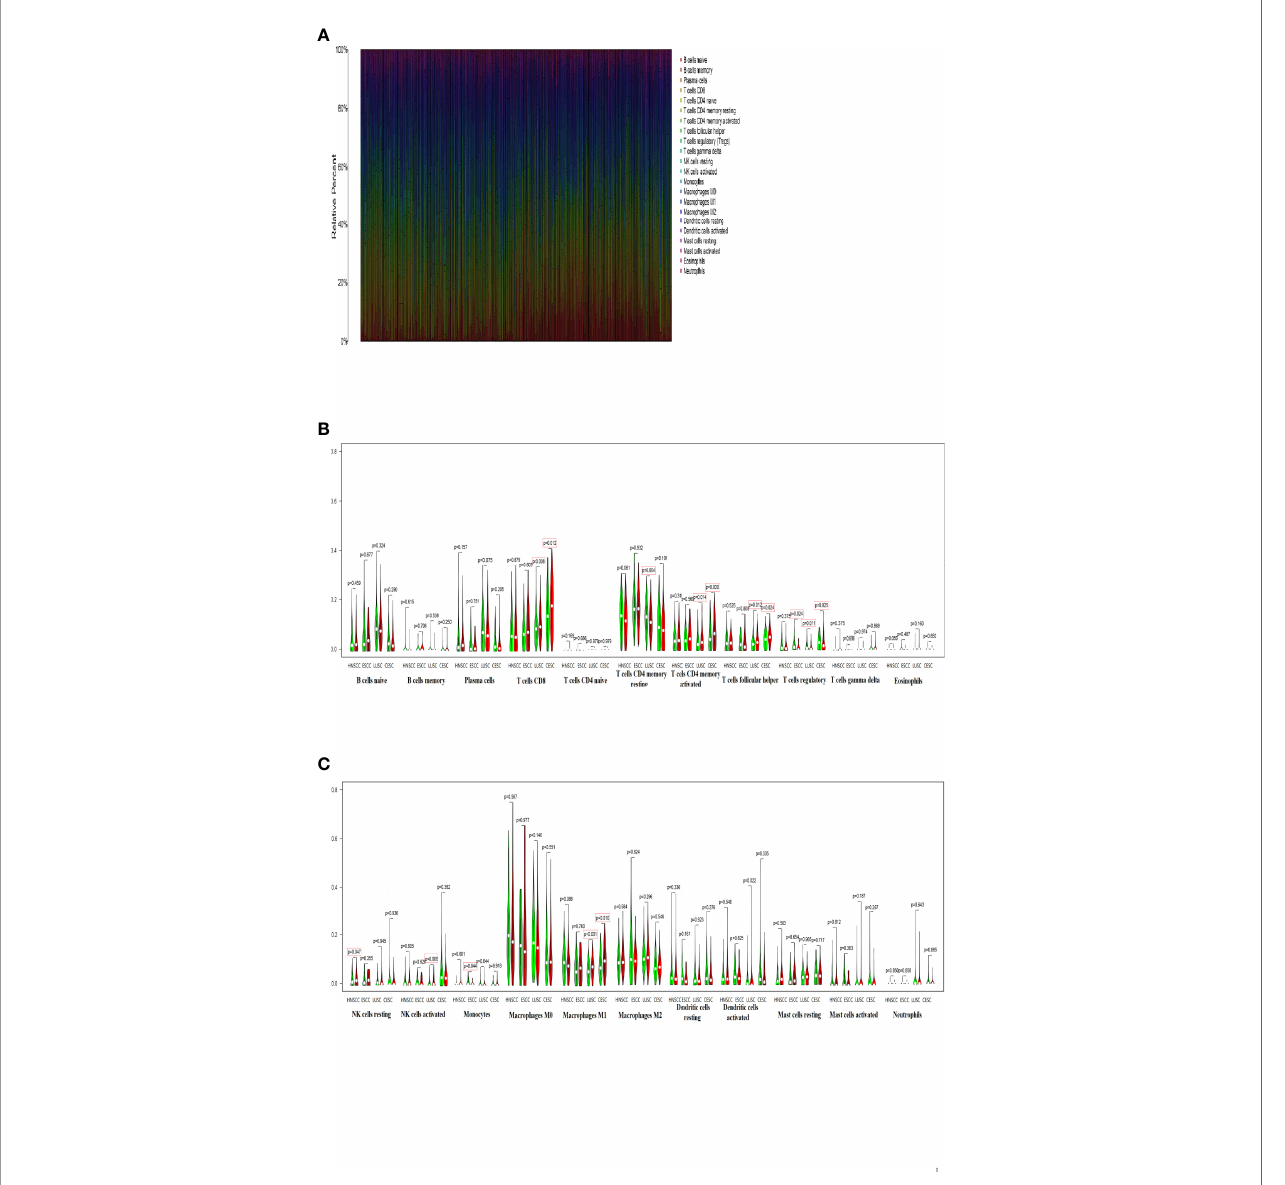
FIGURE 4 | Comparison of immune cell in fi ltrations in different types of SCCs (A) 22 immune cells proportion in each SCC sample were shown in barplot. (B, C) Immune cell in fi ltrations were different between two TMB groups in HNSCC, ESCC, LUSC and